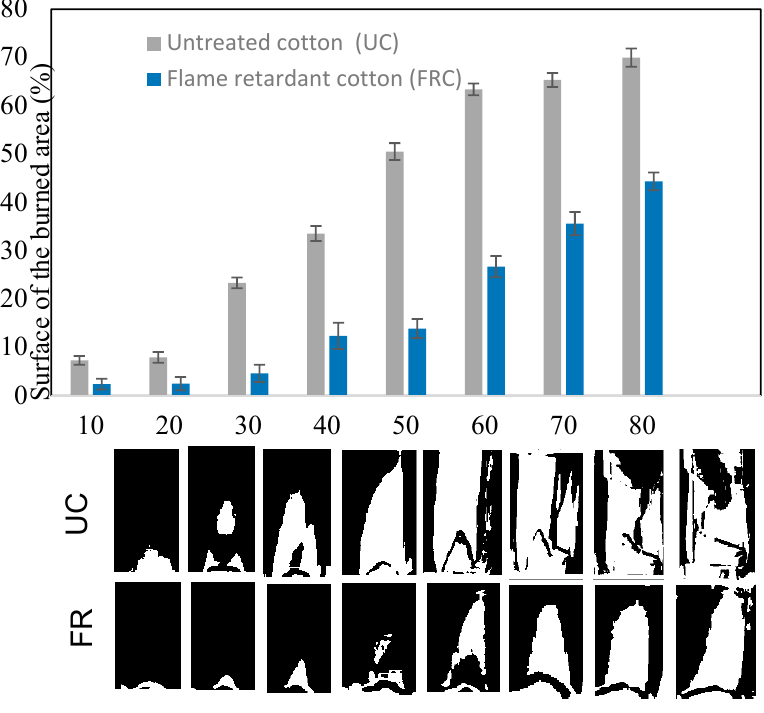
Figure 8. Vertical flammability of untreated cotton (UC) and flame-retardant cotton (FRC). Vertical flammability was quantified by calculating the average percentage ± (standard deviation) of the surface burned area. ImageJ software was used to calculate the burned area (white area) as well as the total surface area.